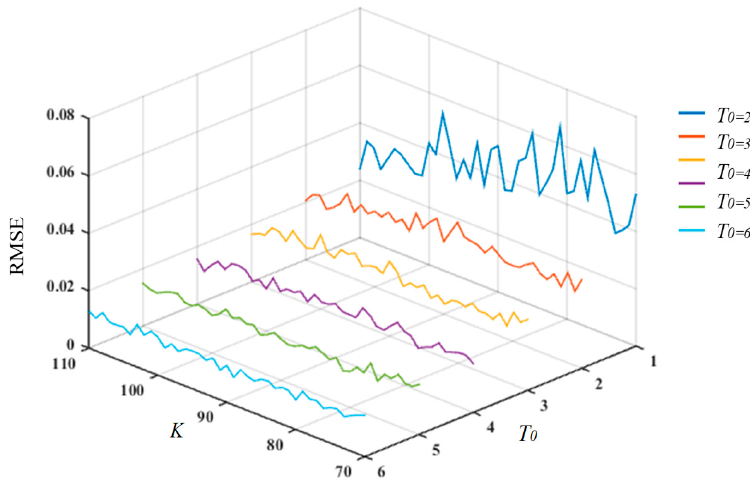
Figure 6. The RMSE of the K-SVD algorithm as the parameters vary.